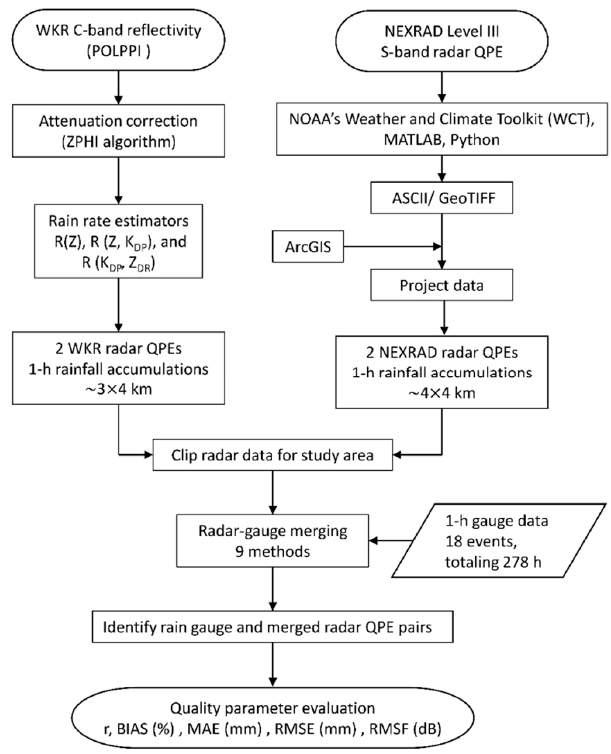
Figure 2. Flow chart showing an overview of the methods and evaluation process.